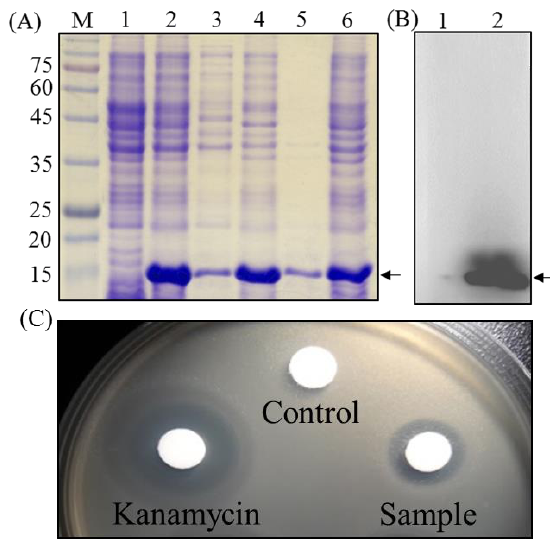
Figure 3. Expression and antimicrobial assay of recombinant peocin in E. coli BL21(DE3). ( A ) SDS-PAGE analysis of protein from the E. coli BL21(DE3)/pET-peocin host; ( B ) The recombinant peocin wasidentified by Western blotting using a 6x-His epitope tag antibody. Lane M: protein marker; 1: total protein without IPTG induction; 2: total protein with IPTG induction at 37 ◦ C; 3 and 5: insoluble proteins with IPTG induction at 37 ◦ C and 27 ◦ C, respectively; 4 and 6: soluble proteins with IPTG induction at 37 ◦ C and 27 ◦ C, respectively; ( C ) Antimicrobial activity assay of recombinant peocin from the lytic supernatant of E. coli BL21(DE3) / pET-peocin. Control and sample indicate the 20 µ L of lytic supernatant from E. coli BL21(DE3) / pET-peocin without and with IPTG induction, respectively. A 10 µ g of kanamycin was used as positive